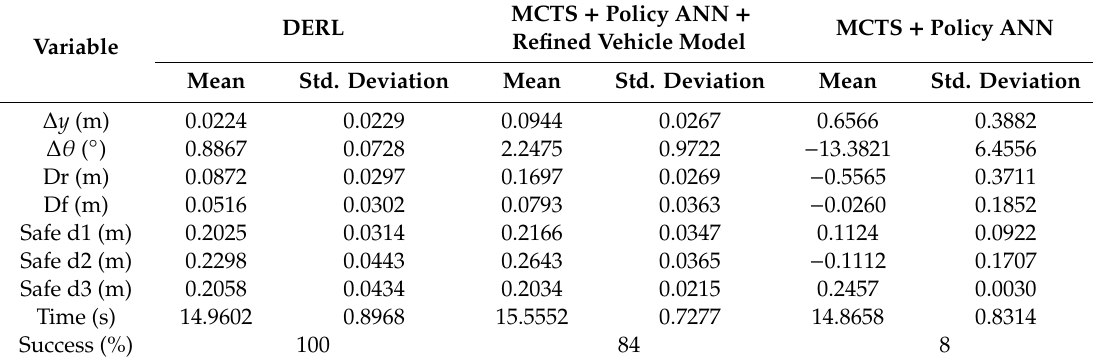
Table 3. Test results for the o ffl ine training positions of 25 × 3 parking trials.